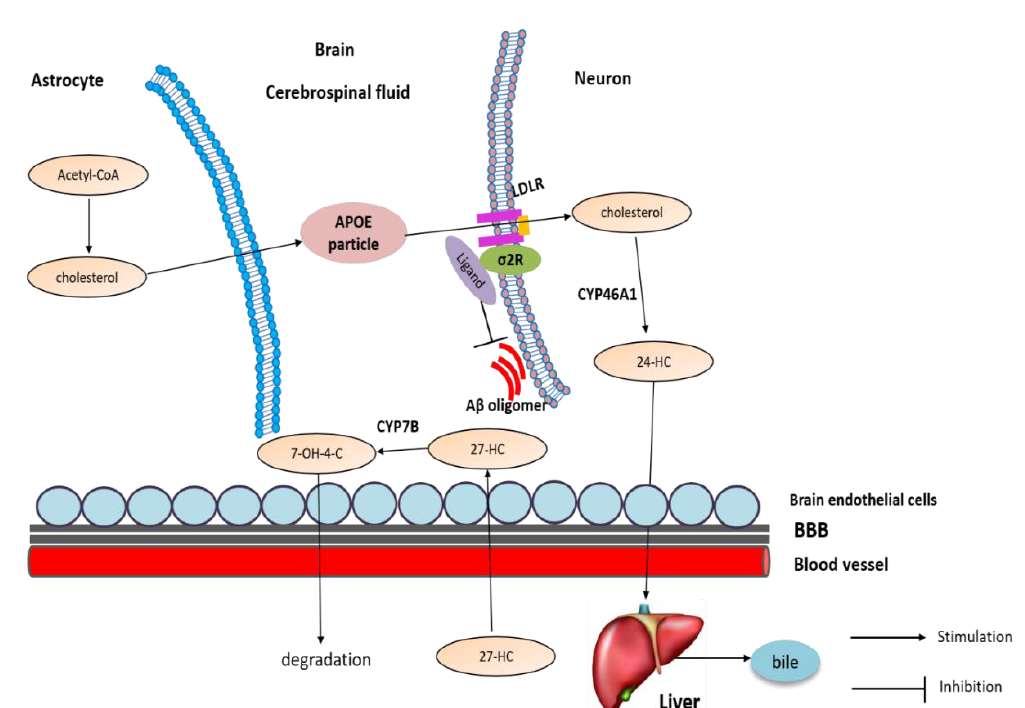
Figure 5. Cholesterol transport and metabolism in brain. Neurons in the adult do not efficiently synthesize cholesterol; they rely on the input from astrocytes as an external source. In neurons, CYP46A1 converts excessive cholesterol into 24-HC, then it is exported out of the brain and carried by LDL to the liver for degradation, while another oxysterol, 27-HC, is produced by CYP27A1 in the periphery and moves into the brain by circulation. Then, 27-HC is converted into 7−OH-4-C by the enzyme CYP7B, which then diffuses out of the brain through the BBB and moves into the periphery for degradation.